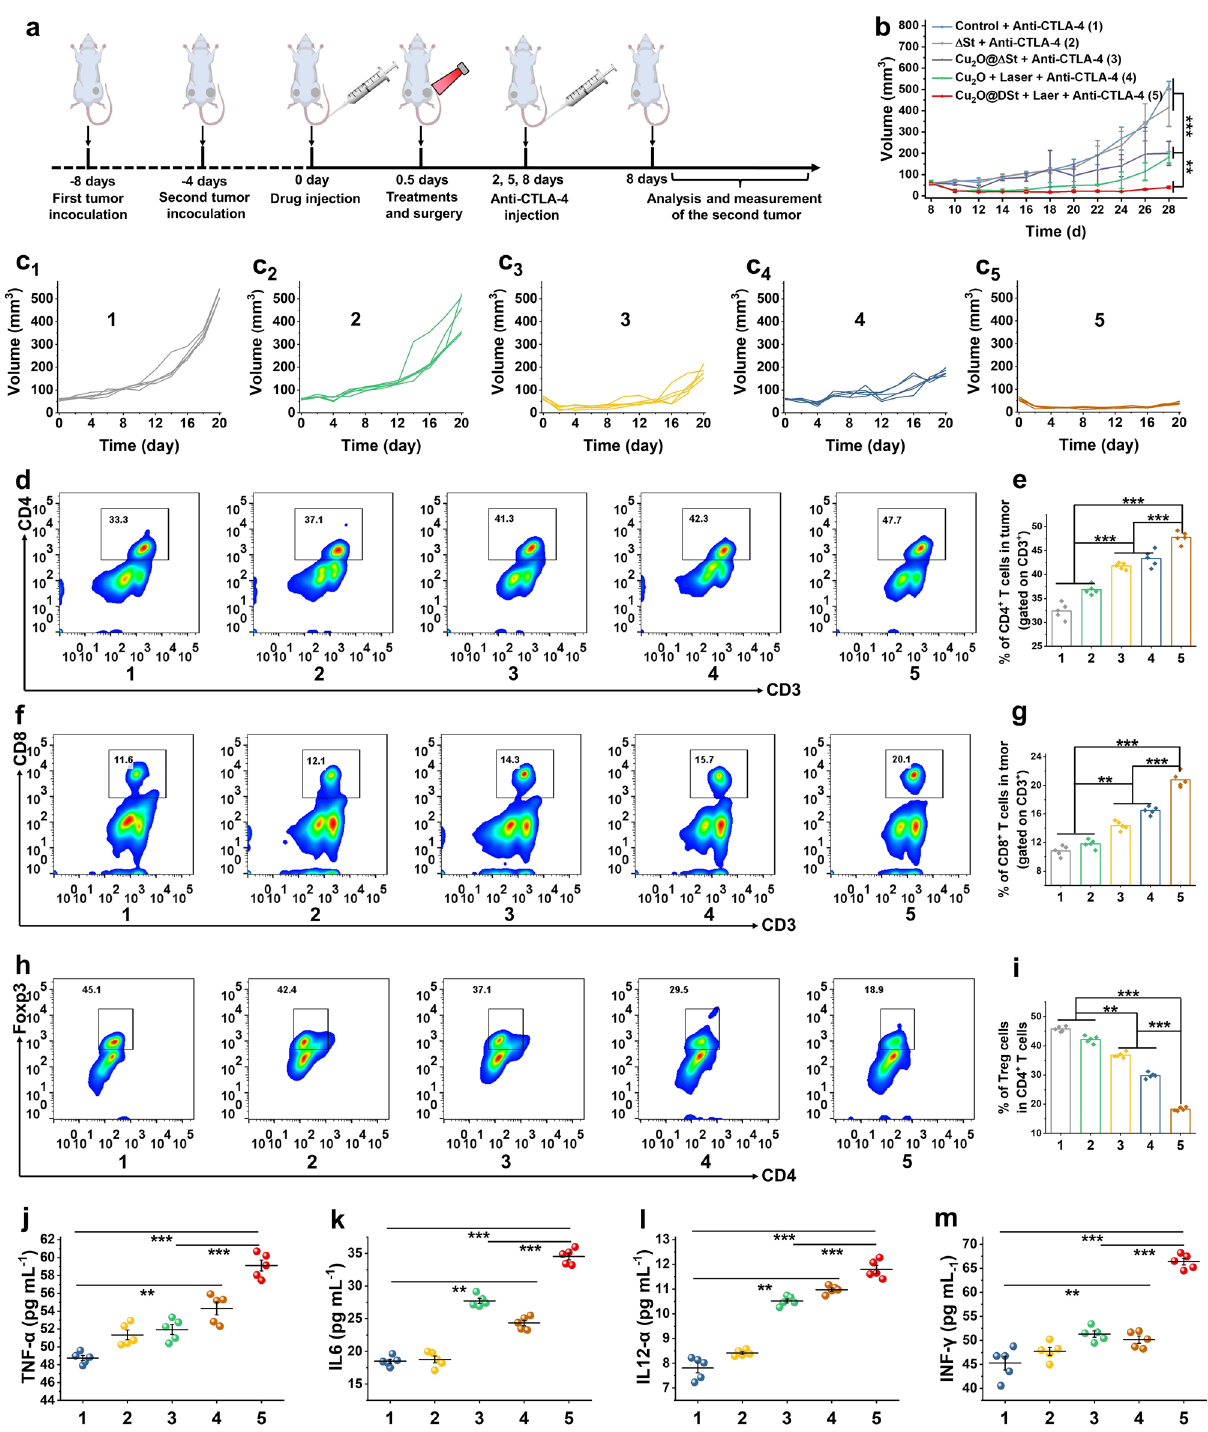
Fig. 5 Anticancer activity of Cu 2 O@ΔSt plus anti-CTLA-4 treatment in murine colorectal cancer models. a Schematic illustration of CT26 tumor-bearing mouse model establishment and treatment procedures in vivo. b Average volume changes of the tumor on the contralateral side of mice in different groups ( n = 5, mean ± standard error). c Volume change curves of contralateral tumor of each mouse after various treatments. d, f Flow cytometry analyses and e, g corresponding quantifications of CD4 + /CD8 + T cells (gated on CD3 + T cells) ( n = 5, mean ± standard error). h FCM analysis and i corresponding quantification of FoxP3 + /CD4 + regulatory T (Treg) cells among CD4. + cells. Secretion levels of j TNF-α, k IL-6, l IL12, and m IFN-γ in serum( n = 5, mean ± standard